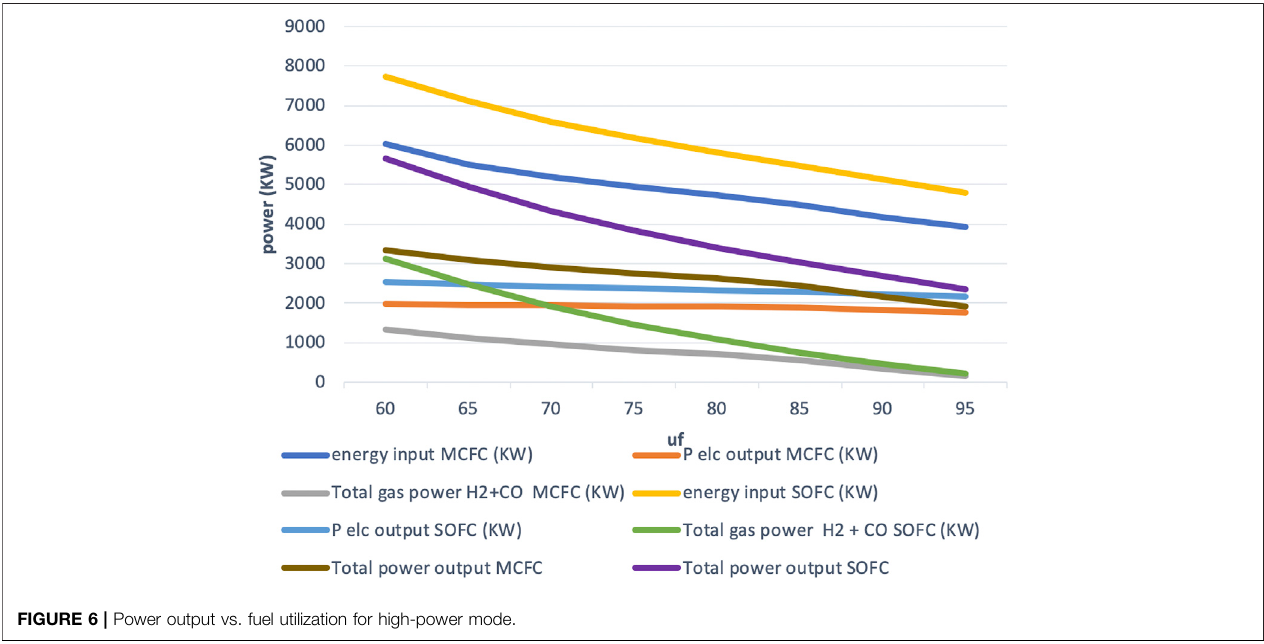
FIGURE 6 | Power output vs. fuel utilization for high-power mode.